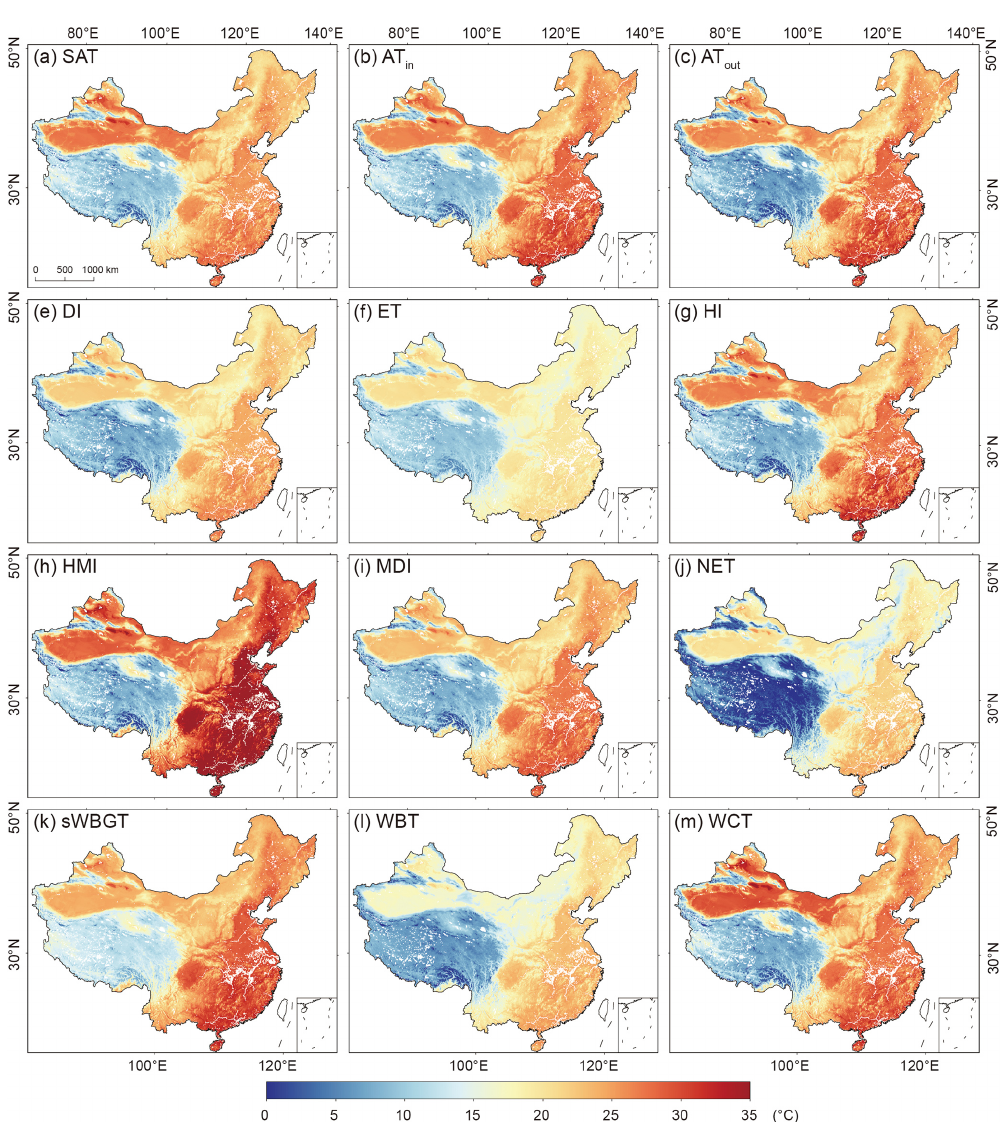
Figure 10. Spatial distributions of the 12 human thermal indices over the mainland of China in July